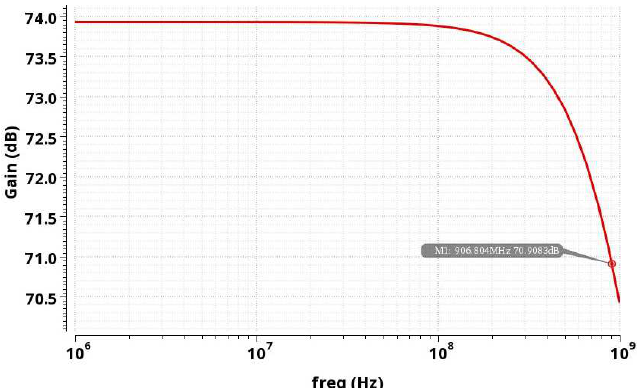
Figure 15. −3 dB bandwidth and gain of receiver AFE including PD.